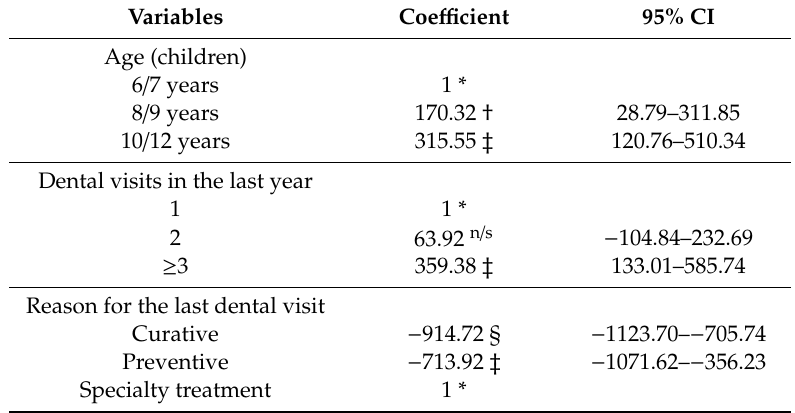
Table 7. Multivariate linear regression models that modeled the amount of OOPEs incurred by families that reported no OOPEs ( n =